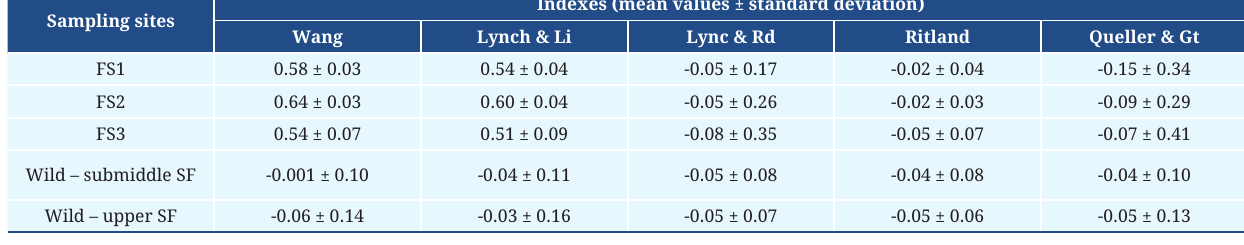
TABLE 4 | Genetic relatedness estimators for three full-sibling families (Bebedouro (FS1), Itiúba (FS2), and LAQUA (FS3) and for wild animals of Lophiosilurus alexandri from the upper and submiddle São Francisco River.